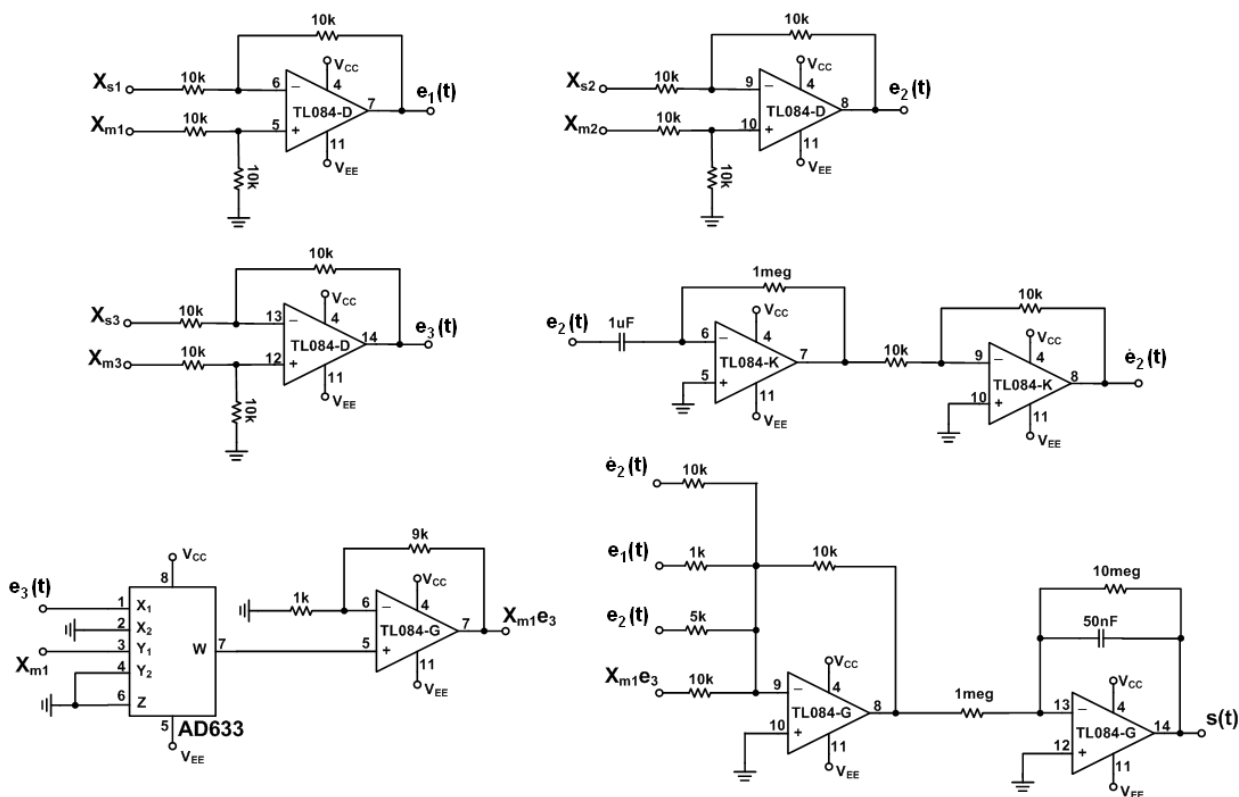
Figure 4. Electronic implementation of the error dynamics e (t) and the switch surface s (t) circuit.